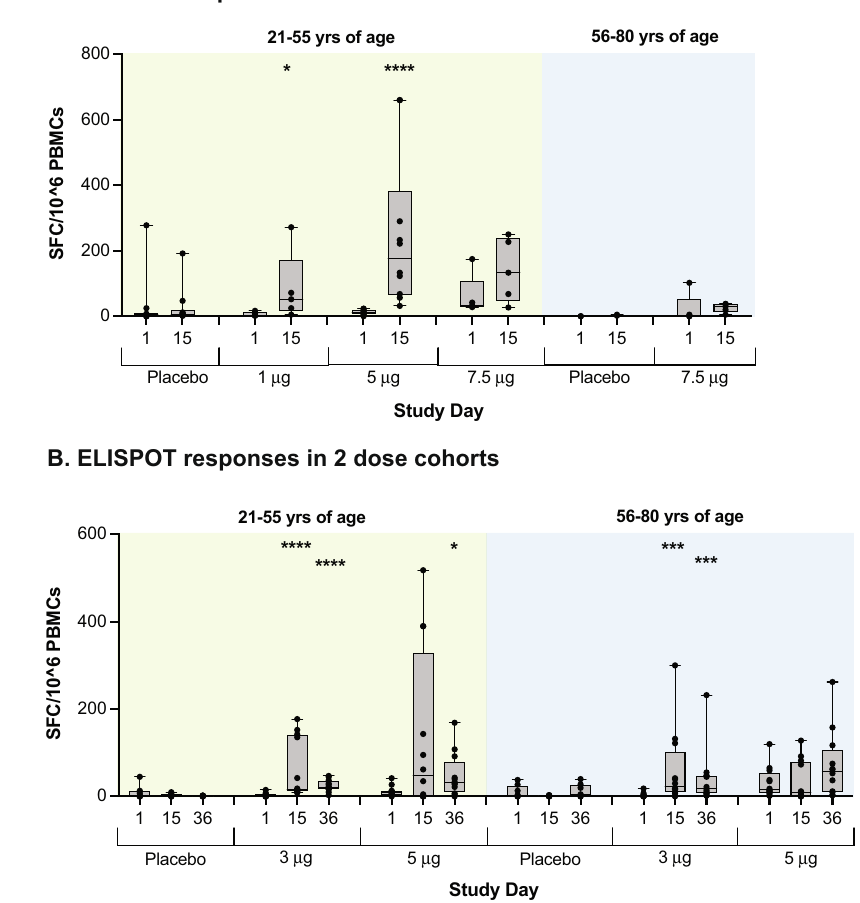
Fig. 5 SARS-CoV-2 speci fi c T-cell responses to ARCT-021. T-cell responses were measured using an interferon gamma (IFN γ ) enzyme-linked immune absorbent spot (ELISPOT) assay and represented as spot-forming cells (SFC) per million PBMCs ( A and B ). Displayed are cumulative ELISPOT results for four peptide pools spanning the SARS-CoV-2 Spike. The data are represented as box and whisker plots where the middle horizontal line marks the median. Each dot represents an individual participant. Within each cohort, antibody data from each timepoint were compared to baseline (i.e., day 1) using Mann – Whitney U test ( P -values marked with *0.01 < P < 0.05, **0.001 < P < 0.01, ***0.001 < P < 0.01, **** P <